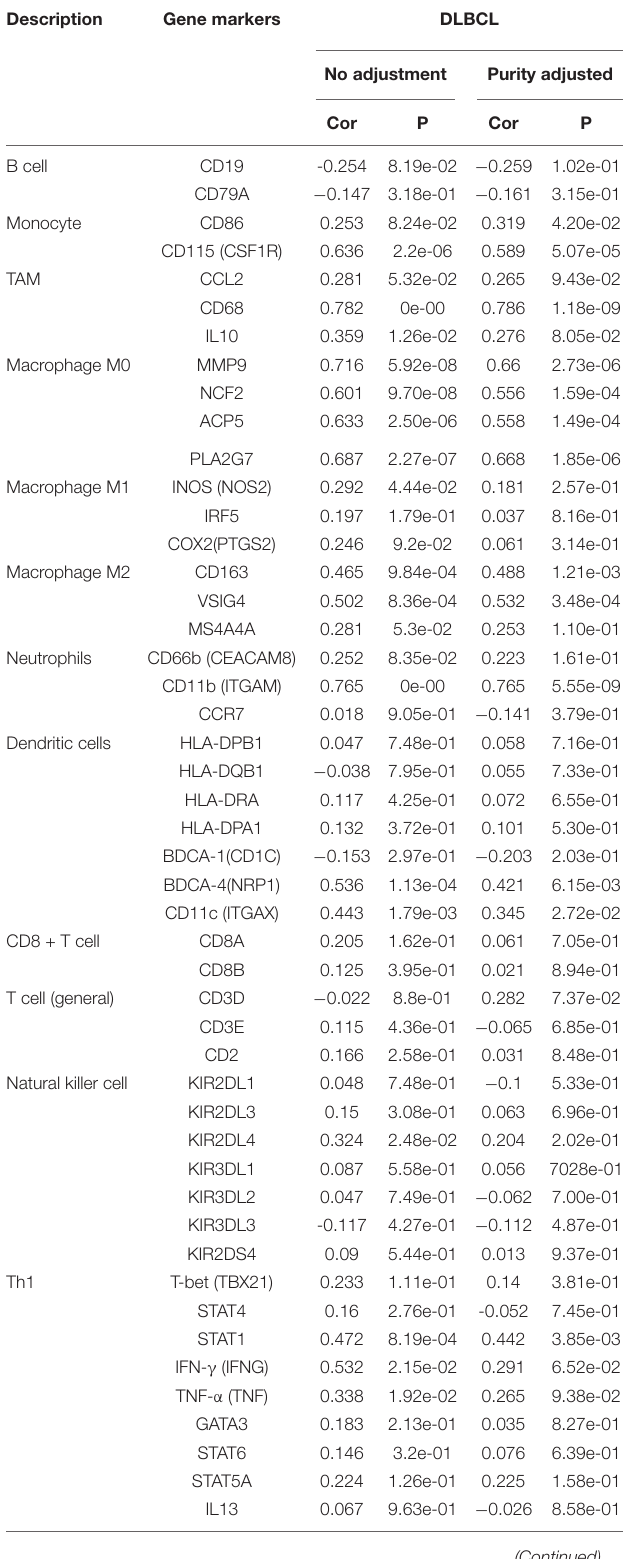
TABLE 2 | Correlation analysis between MMP14 and immune cell-related genes and markers, as assessed with Tumor Immune Estimation Resource (TIMER).